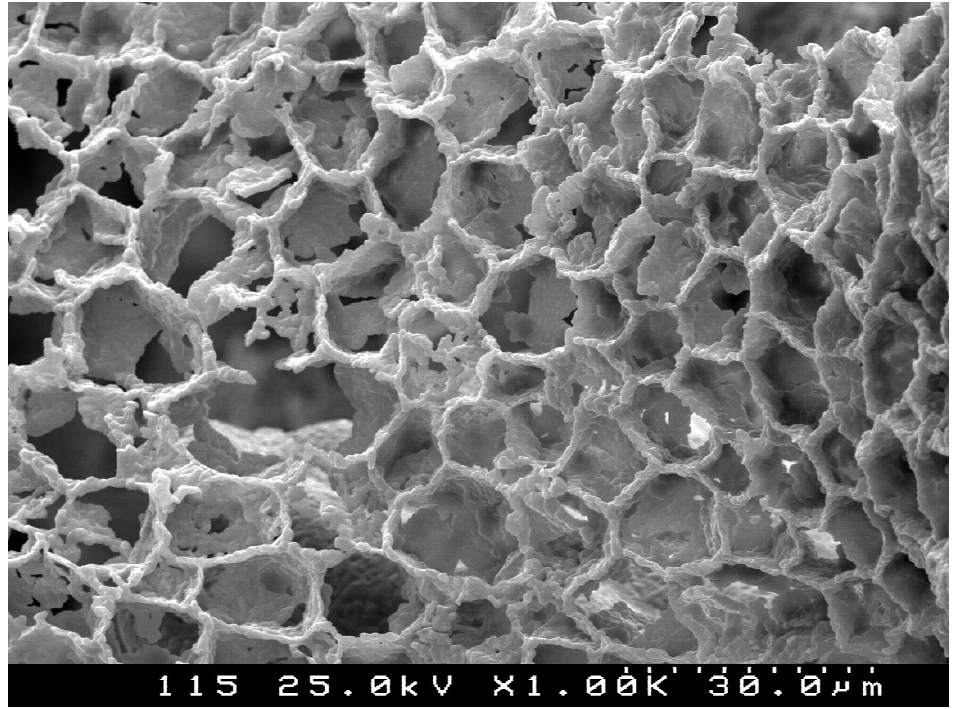
Figure 5. Magnetic hexaferrite ecoceramics with cork cellular microstructure (scanning electron microscope (SEM)) image courtesy of Pullar